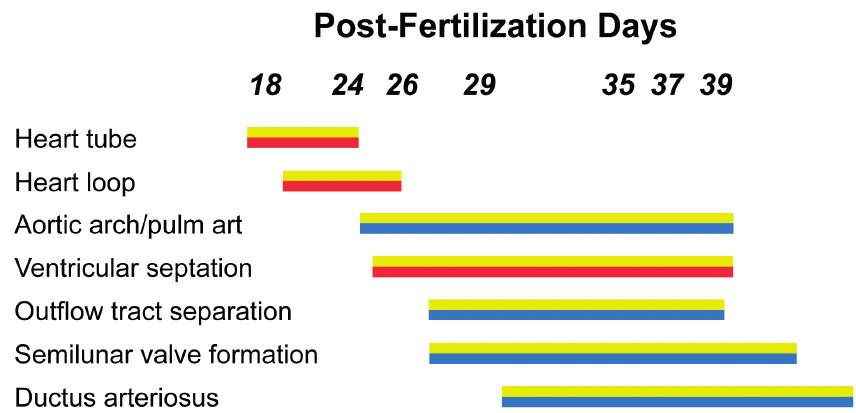
Figure 1. Timeline of outflow tract and semilunar valve development post-fertilization. The colors represent contributions to cardiac development from different cell populations. These contributions are from the first heart field (red), second heart field (yellow) and cardiac neural crest (blue). Modified from